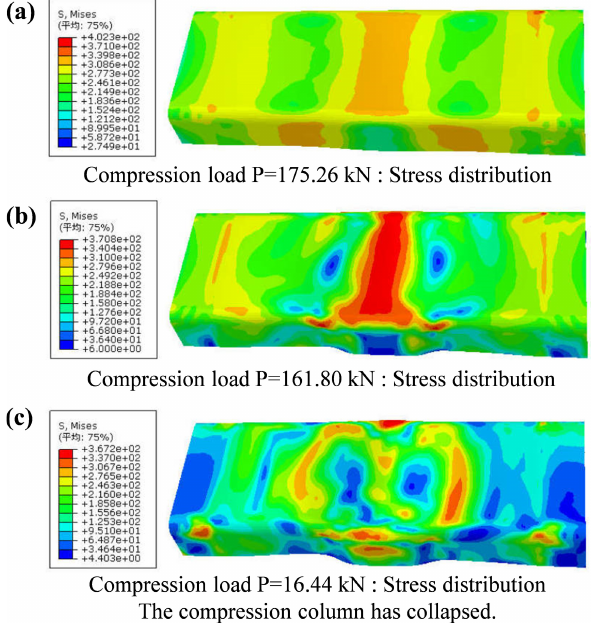
Figure 13: Stress and deformation process of the outer aluminum alloy sheet of the DCYG-B